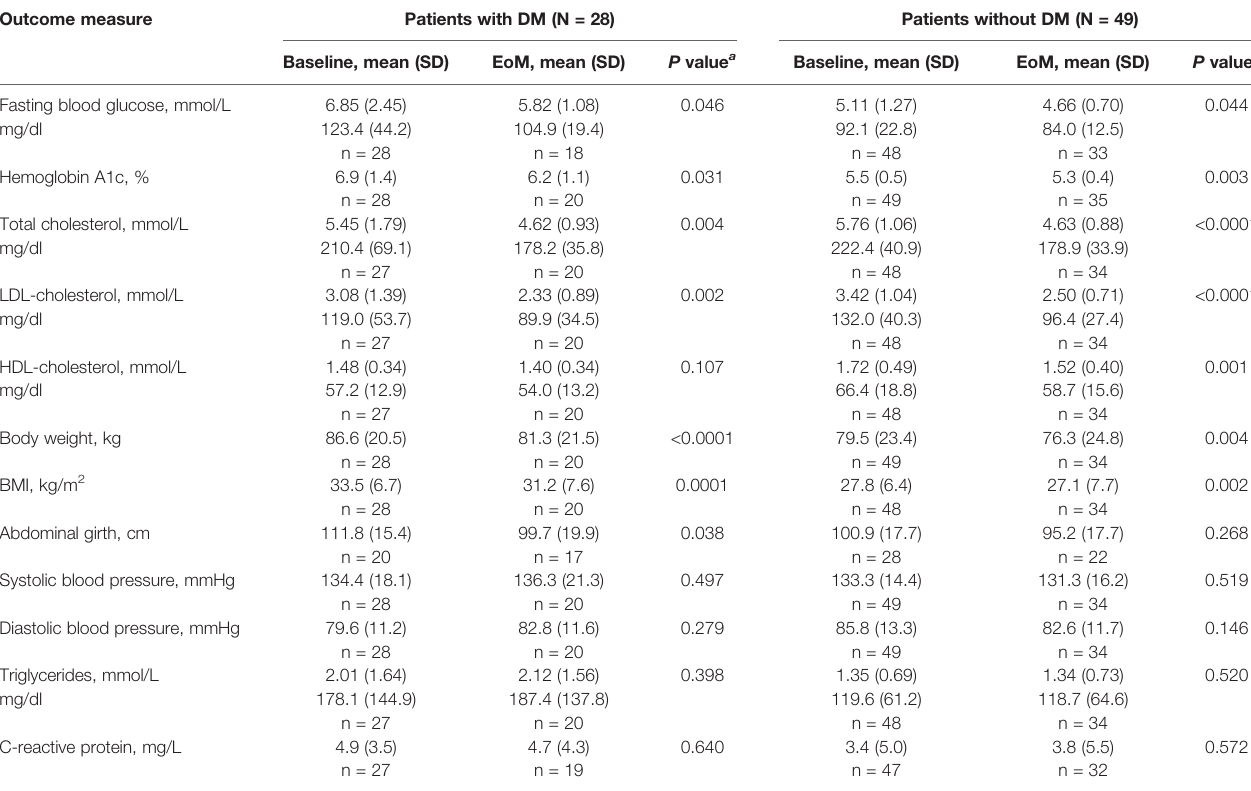
TABLE 3 | Change in key secondary endpoints from baseline to end of the maintenance phase (maintenance population). Outcome measure Patients with DM (N = 28)